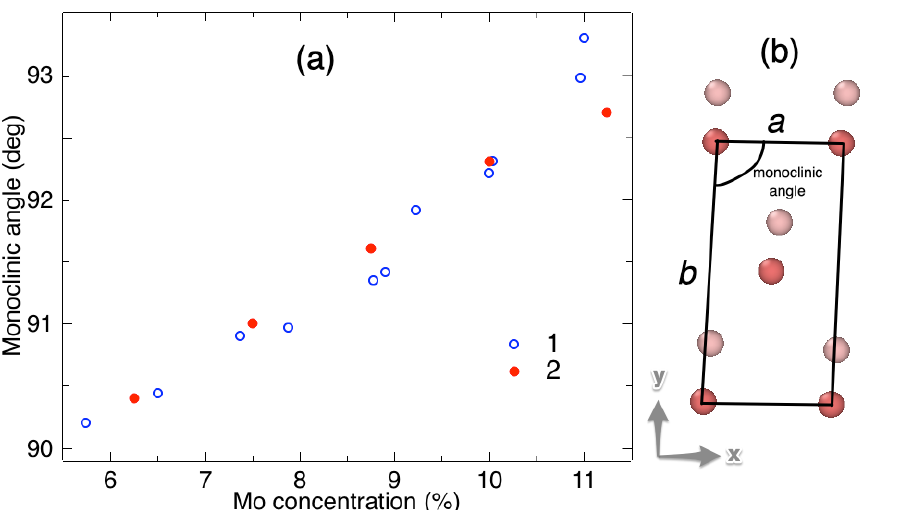
Figure 1. ( a ) The monoclinic angle of the α (cid:48)(cid:48) -phase at room temperature (for various Mo concentrations): 1—values measured in work [32]; 2—calculated data from this work. The inset shows the monoclinic angle of equivalent cell of the γ 0 -phase at room temperature dependent on the Mo concentration. ( b ) Projection of atomic positions in the α (cid:48)(cid:48) -phase unit cell onto its [001] plane. Red atoms correspond to the z = 0 plane and pink atoms to the z = 0.5 c